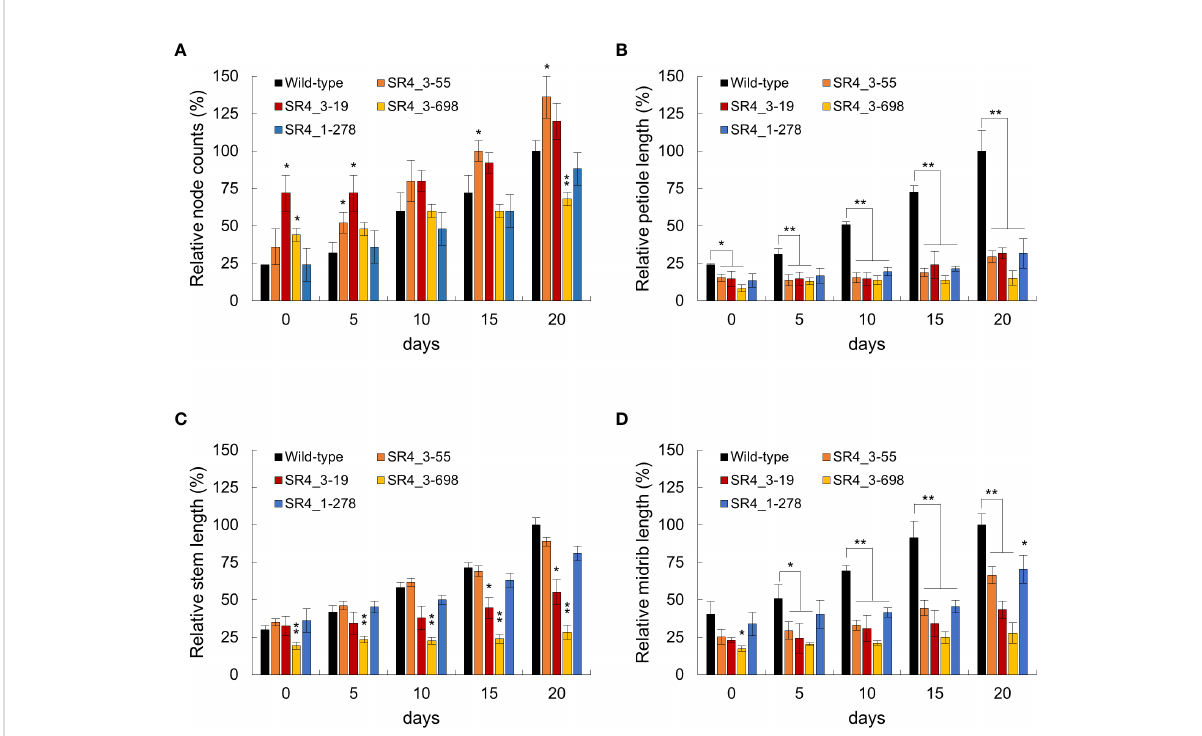
FIGURE 4 Phenotypic characterization of wild type and stsr4 mutants ( stsr4_3-55 , stsr4_3-19, stsr4_3-278 , and stsr4_3-698 ). Plants were grown in vitro for 20 days at 16 h light/8 h dark. Representative whole plant phenotypes in wild type and stsr4 mutants. The typical phenotype with node counts (A) , petiole length (B) , stem length (C) , and midrib length (D) of each genotype was observed and photographed every 5 days. Node counts (number), petiole, stem, and midrip length (mm) of 20 days old wild-type plants were 8.3 ± 0.57, 10.73 ± 1.47, 38.37 ± 1.85, and 11.63 ± 0.85, respectively. Values represent the mean±SE of six replicated experiments (each mean value represents the measured phenotype of four plants). Bars indicate SE. Student ’ s t-test; *p<0.05,